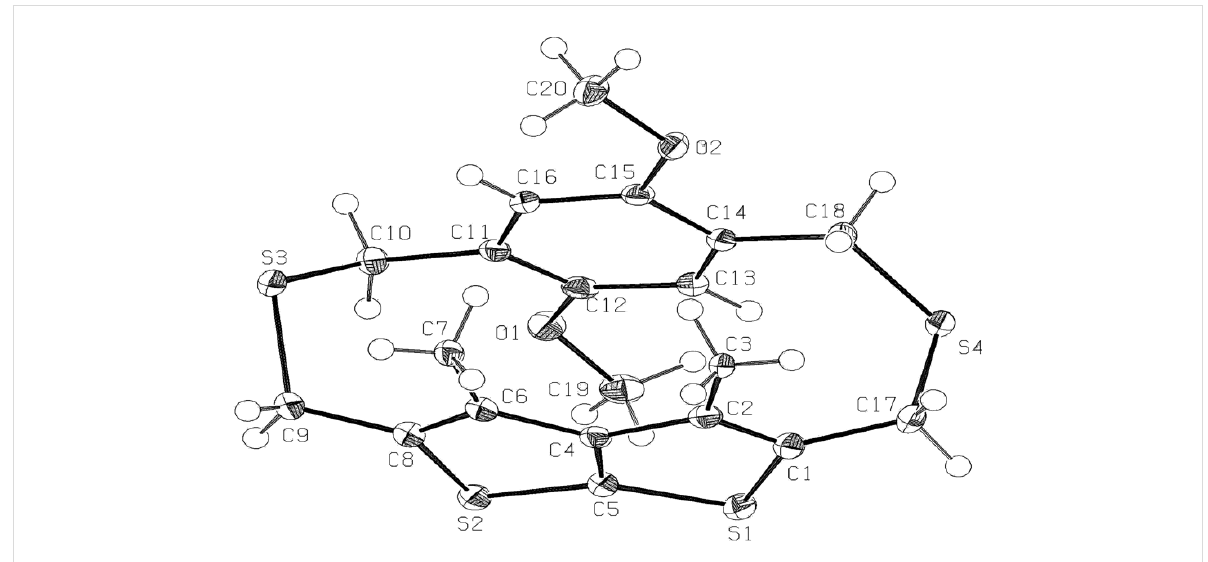
Figure 2: ORTEP plot of the crystal structure of 11 . Important parameters: Bond length (Å) : C8–C9 = 1.492, C1–C7 = 1.497, C10–C11 = 1.517, C14–C18 = 1.522; Bond Angles (deg): C4, C6, C7 = 124.70, C1, C2, C3 = 125.03, C10, C11, C12 = 120.31, C13, C14, C18 = 123.14, C10, S3, C9 = 104.13; C18, S4, C17 = 101.14, C16, C11, C10 = 121.12 C15, C14, C18 = 118.43; Dihedral Angles (deg): C18, C14, C15, C16 = −174.40(13), C10, C11, C12, C13 = −175.43(14), C10, C11, C16, C15 = 178.80(13), C15, C16, C11, C12 = −2.7(2), C12, C13, C14, C15 = −3.1(2), C8, C6, C4, C6 = 168.50(16), C1, C2, C4, C6 = −167.65(16), C5, C4, C2, C1 = 5.29.